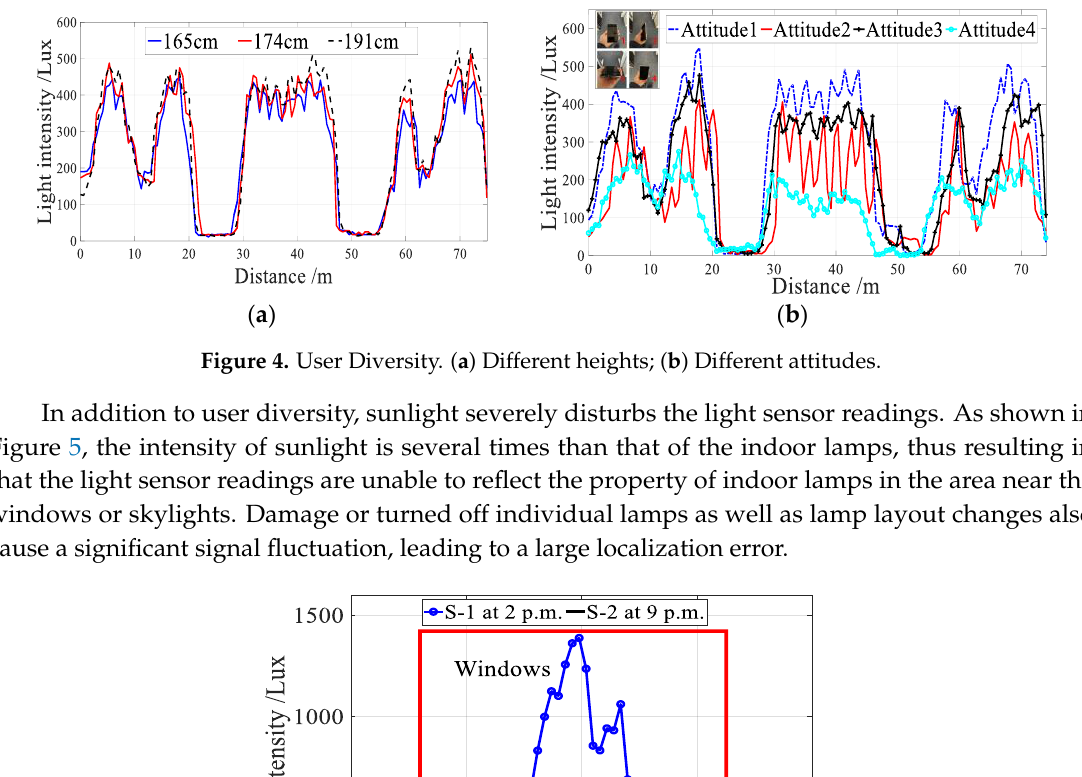
Figure 5. Sunlight disturbs light sensor readings obviously.